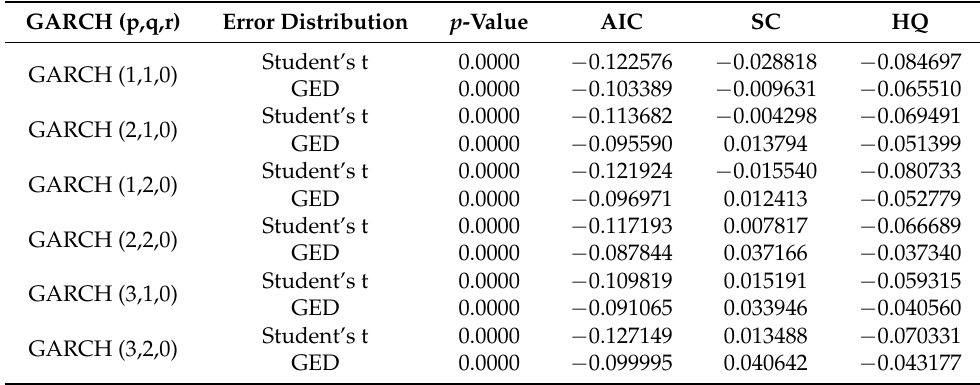
Figure 6. Performance comparison of LSTM with different numbers of batches and windows. ( a ) The performance of LSTM with varying numbers of windows when batches number is 40. ( b ) The performance of LSTM with varying batch size when windows number is 50. Table 5. AIC, SC, and HQ results of the GARCH model with different